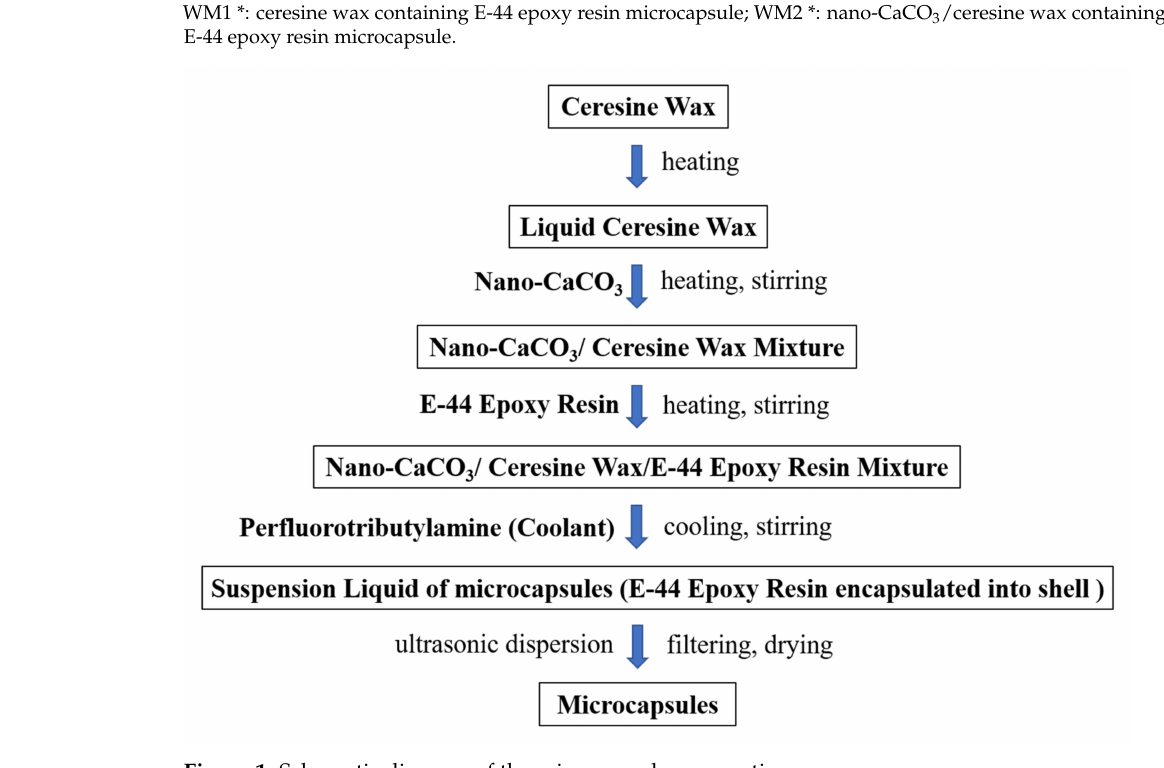
Figure 1. Schematic diagram of the microcapsule preparation process.